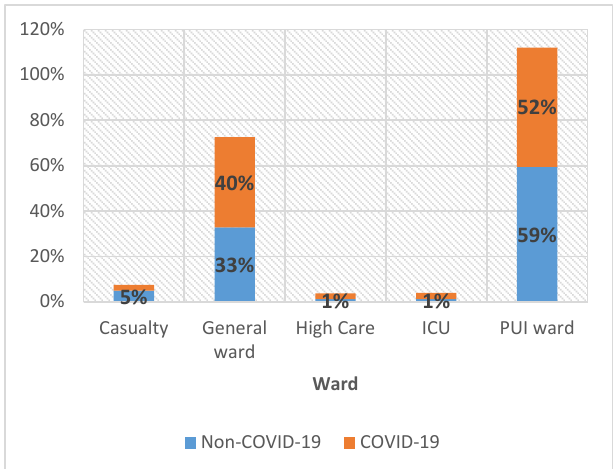
Figure 3. Prevalence of mortality among individuals with laboratory-confirmed SARS-CoV-2 according to the ward ( p –value = 0.815).